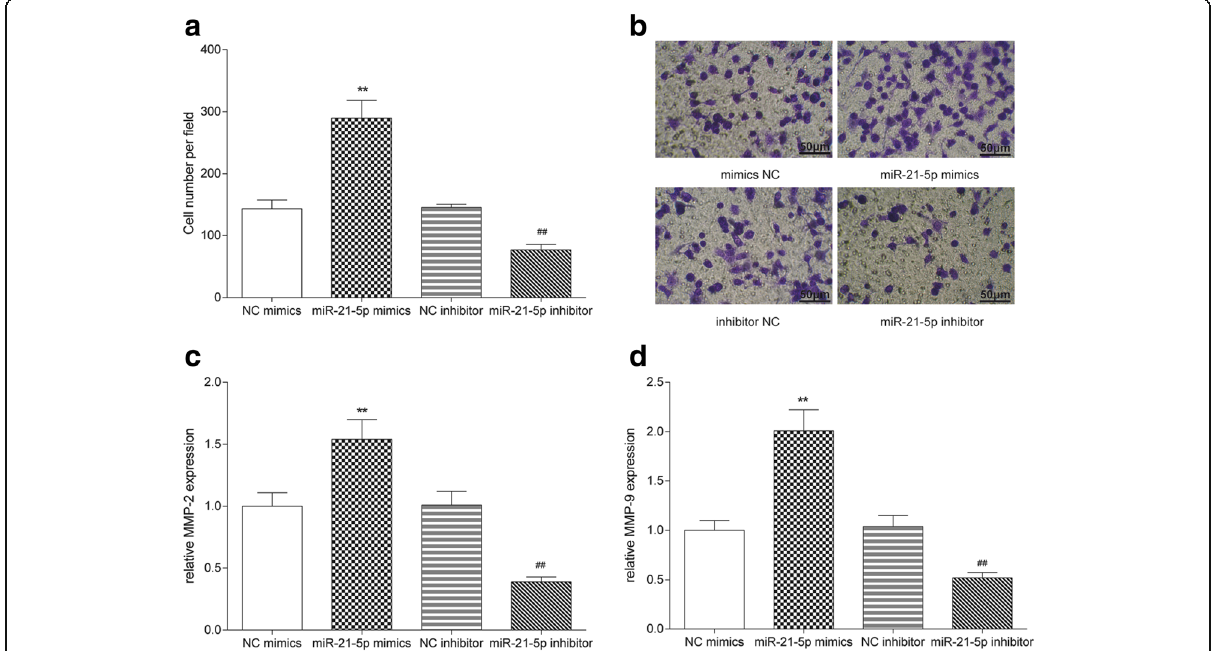
Fig. 5 MiR-21-5p promoted the invasion of COAD cells. a , b Cell number in miR-21-5p mimics group was more than that in NC mimics group, while that in miR-21-5p inhibitor group was less than that in NC inhibitor group detected by transwell assay. The scale bar was 50 μ m. c , d The expressions of invasiveness-related factor MMP-2 and MMP-9 in miR-21-5p mimics group were higher than that in NC mimics group, while those in miR-21-5p inhibitor group were lower than that in NC inhibitor group detected by ELISA. ** P < 0.01, compared with NC mimics group, ## P < 0.01, compared with NC inhibitor